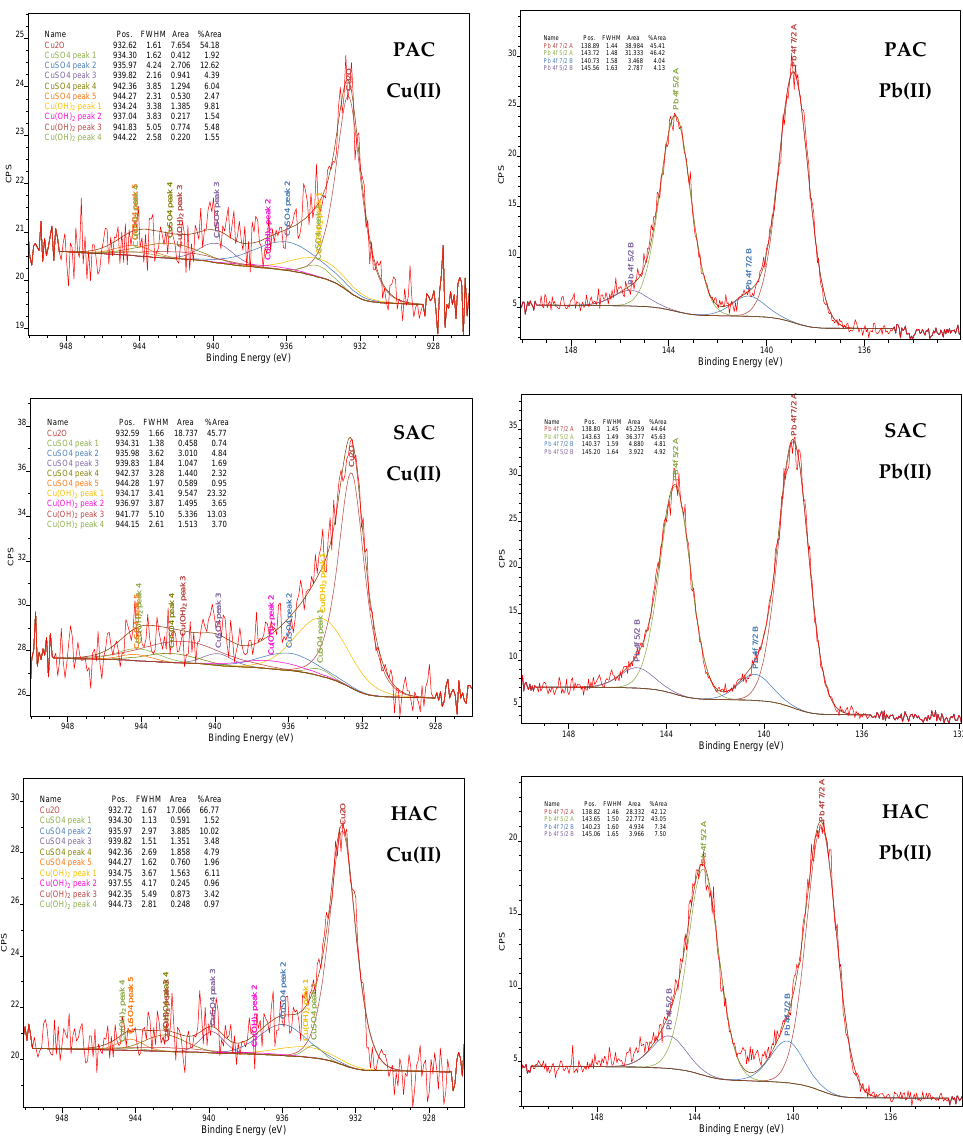
Figure 7. The Cu 2p and Pb 4f spectra of activated biocarbons after heavy metal ions adsorption.